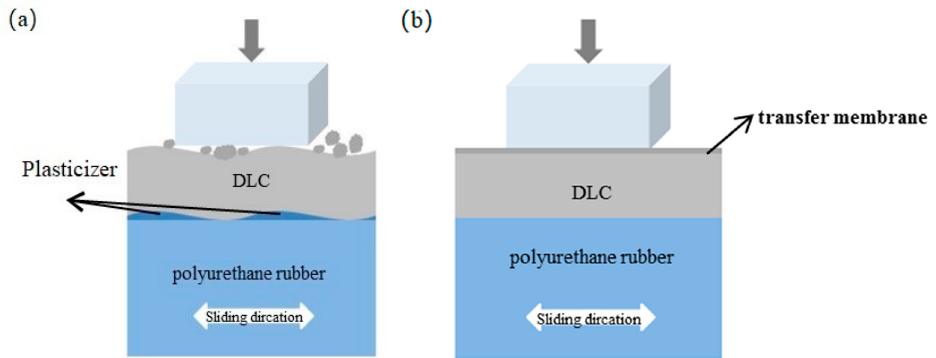
Figure 7. Schematic diagrams of wear mechanisms for DLC films deposited on two different substrates: ( a ) PU rubber without the pre-treatment, ( b ) PU rubber with the pre-treatment.